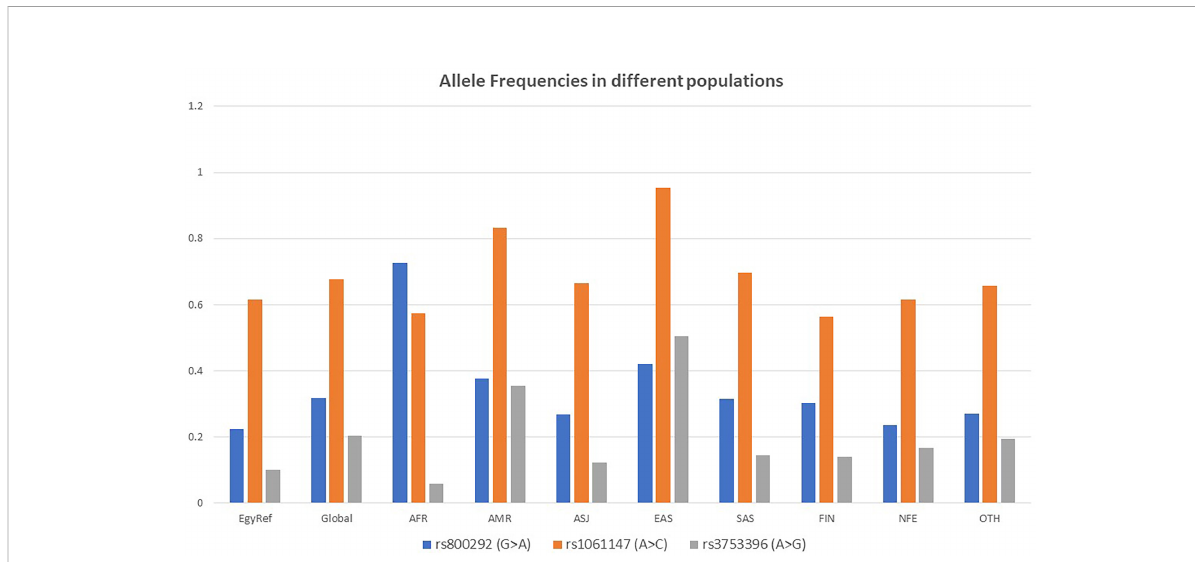
FIGURE 1 Allele Frequencies of the detected recurrent SNPs in different populations according to gnomAD. EgyptRef, Egyptian Genome Reference; AF, Global (gnomAD: Exomes); AFR, African; AMR, American; ASJ, Ashkenazi Jewish; EAS, East Asian; SAS, South Asian; FIN, European (Finnish); NFE, European (Non-Finish); OTH, Other.